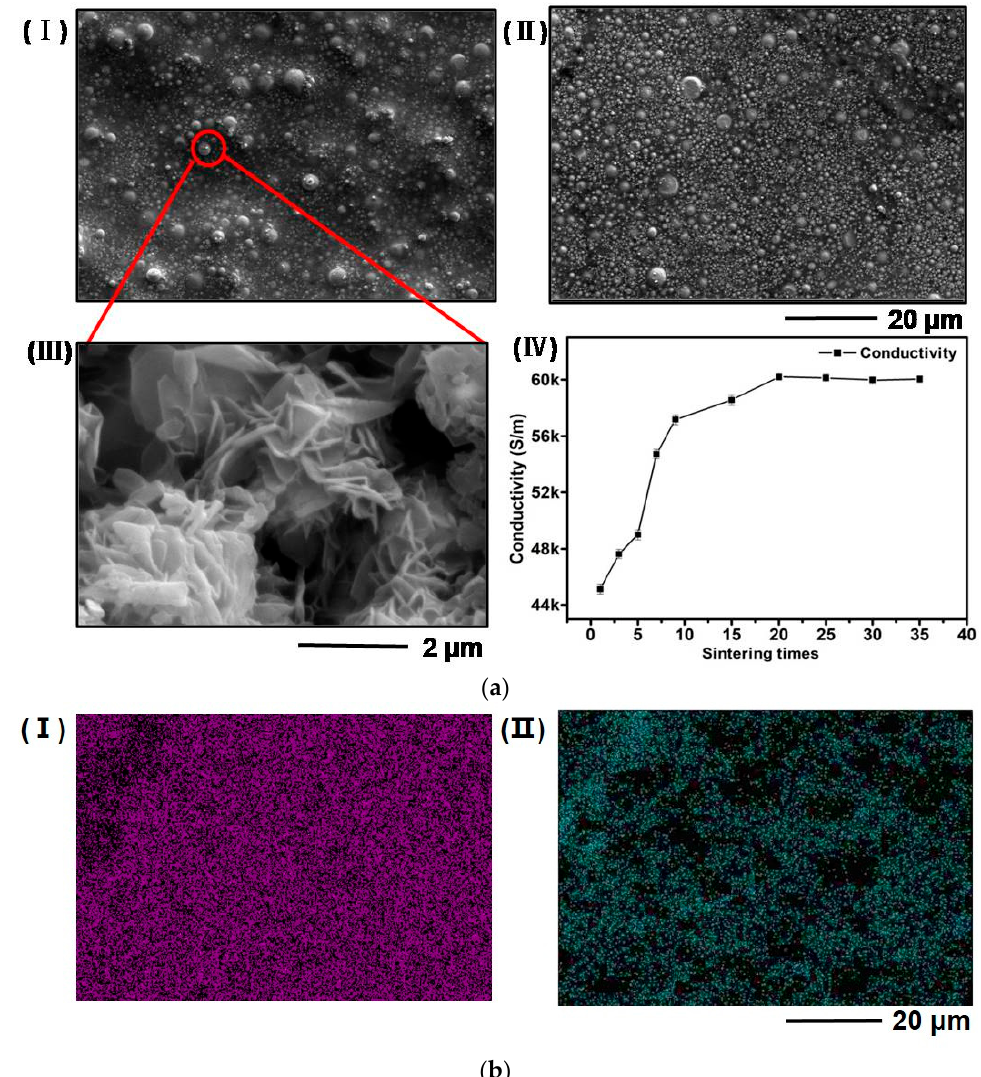
Figure 3. ( a ) ( I ) and ( II ) represent that patterns treated with 20 and 25 light pulses, respectively; ( III ) a higher resolution of SEM image of surface morphology of Zn NPs after treating with 20 pulses of photonic sintering; ( IV ) The changes of conductivity with different number of light pulses in the photonic sintering process; ( b ) The mapping of a printed pattern shows the distribution of Zn ( I ) and O ( II ).